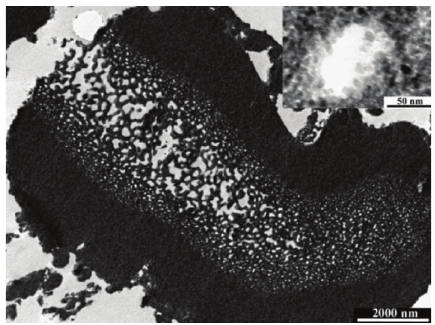
Figure 4: Cross-section TEM images of hierarchically mesostruc- tured titania with an interior macroporous structure